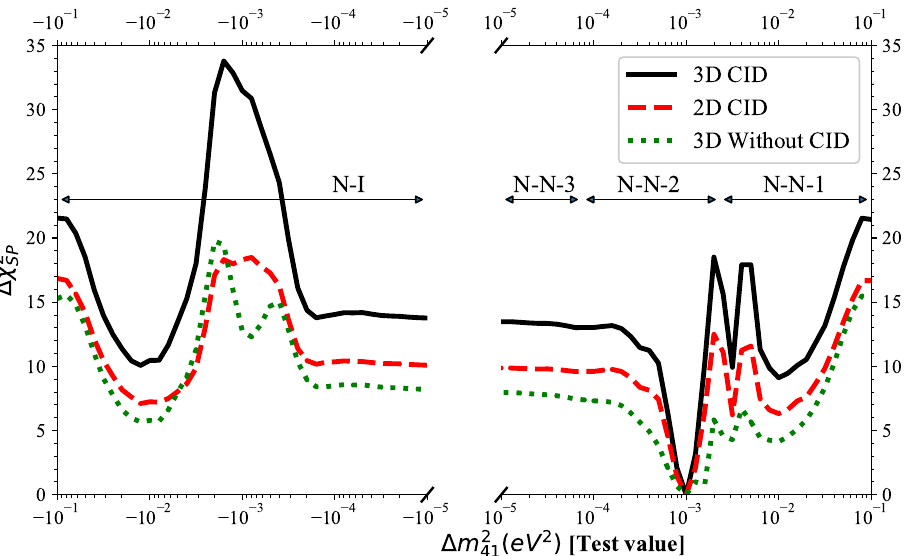
Figure 10 . The (cid:1) (cid:31) 2 [see eq. (5.1)] at test values of (cid:1) m 2 SP true value is (cid:1) m 2 = 10 (cid:0) 3 eV 2 (corresponding to N-N-2). The mixing parameters are taken to be 41 j U e 4 j 2 = 0 : 025, j U (cid:22) 4 j 2 = 0 : 05, and j U (cid:28) 4 j 2 = 0. The results have been presented with and